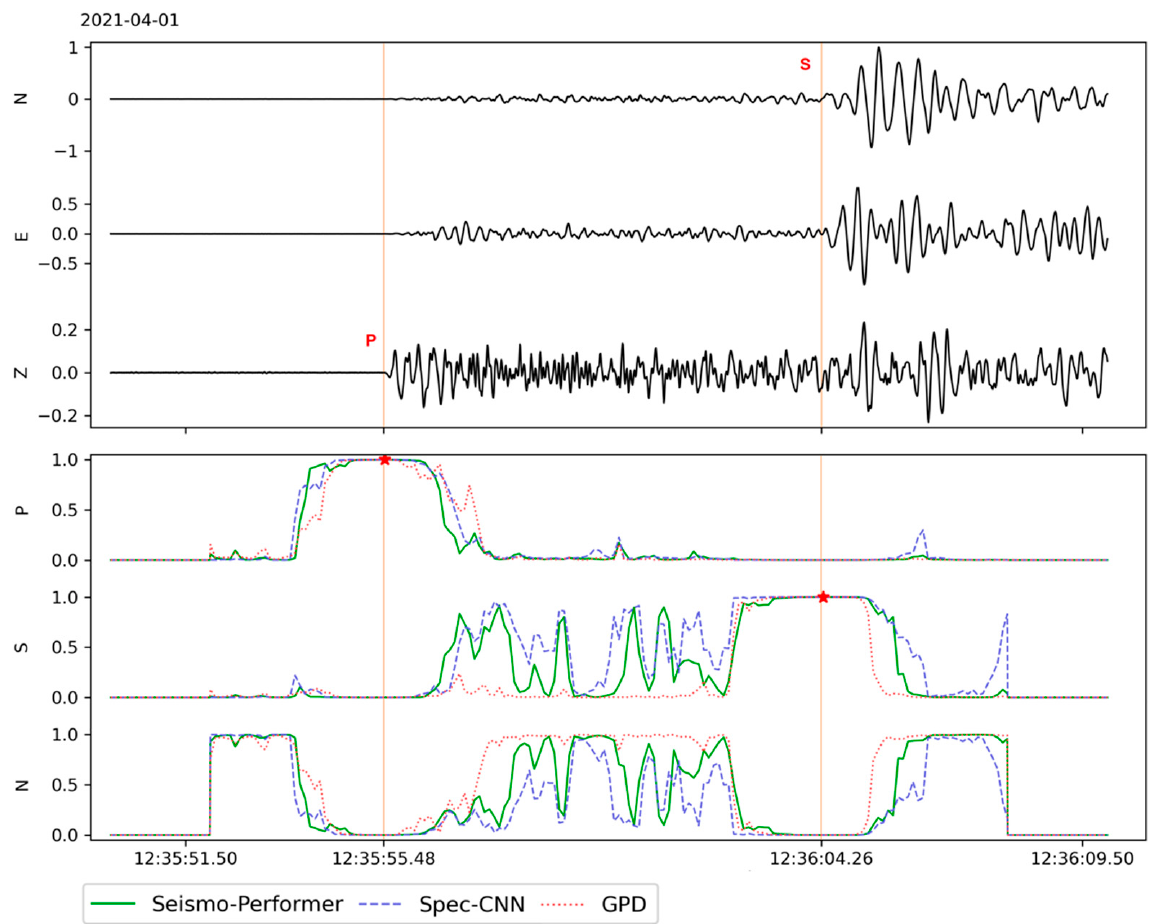
Figure 5. An example of the model’s prediction during the processing of a 1 min seismogram. This is the NYSH seismic station with a 3-channel component “ENZ” (East, North, Vertical) located 97 km from the epicenter of an M3.1 local earthquake on northern Sakhalin [18]. “P”, “S” and “N” indicate the probability (SoftMax values) of predicting P/S phases and noise, respectively. The red vertical lines are the manually picked P and S arrival times. The pentagrams show the maximum SoftMax values for predicting the seismic phase class, which are nearly the same for each model.